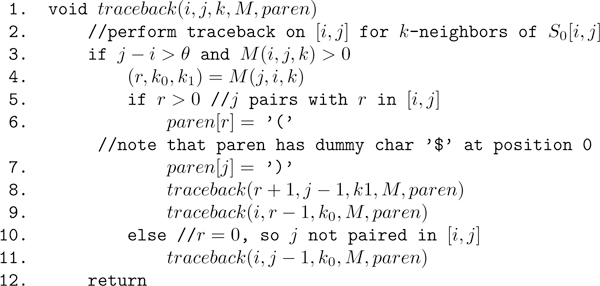
Pseudocode for the O(n2) traceback computed by our RNAborMEAalgorithm. Note that run time could be reduced to O(n ln n) by applying the boustrephedonic method described in [42].